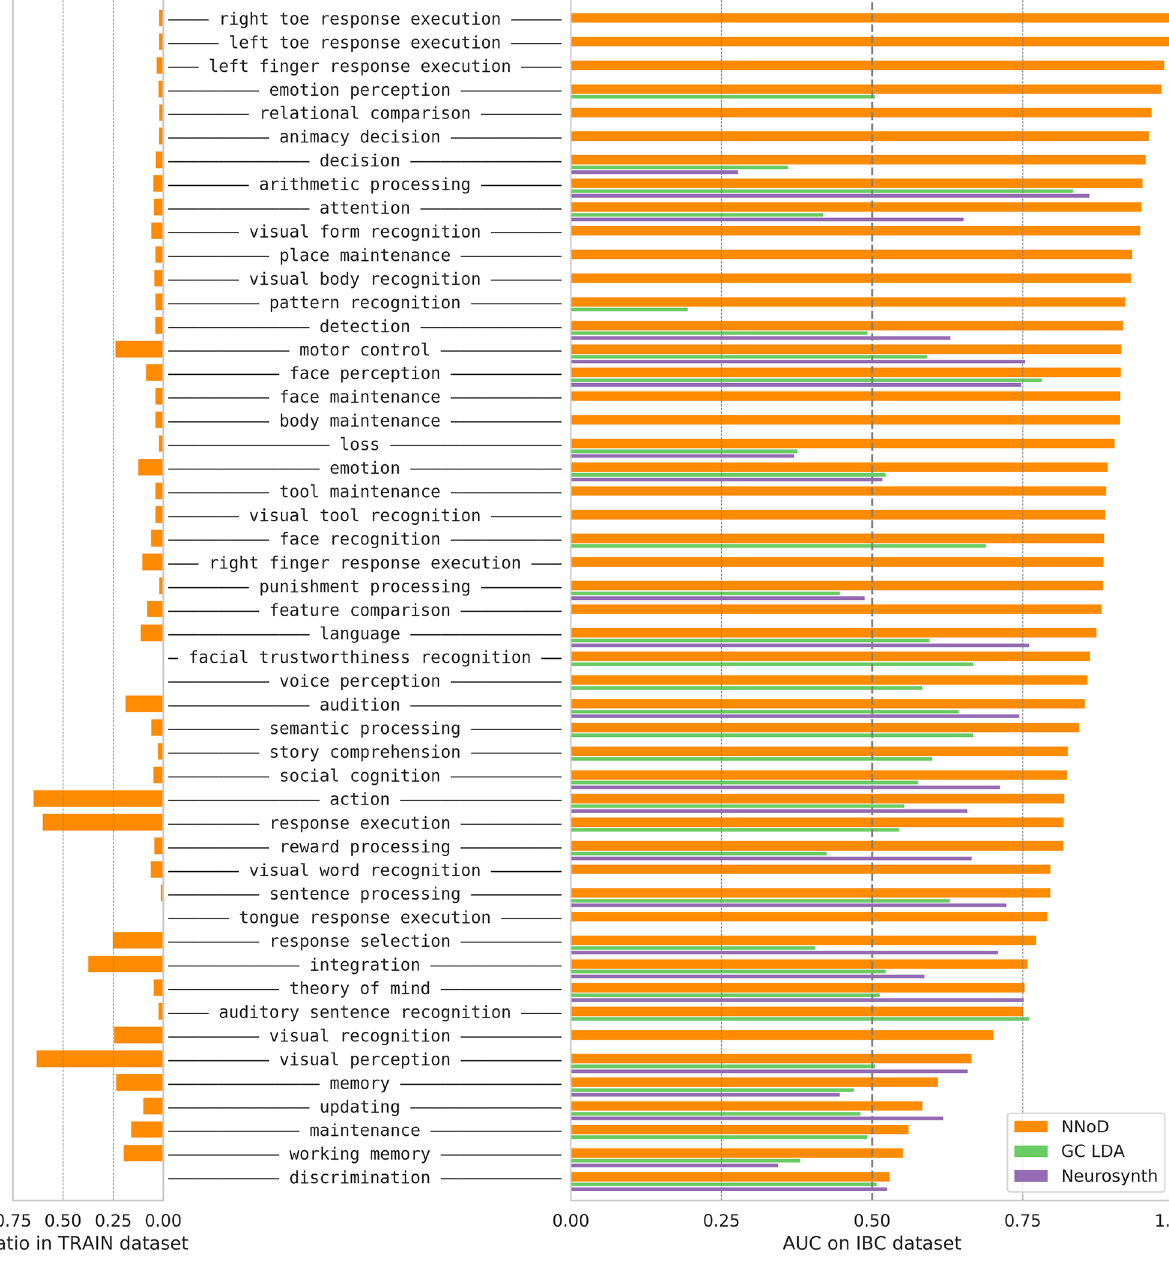
Figure 5. Decoding performance on enriched concepts. Compared with original labels decoding, after enriching the training dataset with heuristics, a similar model manages to decode more labels (51 in the test dataset) with an overall better accuracy.